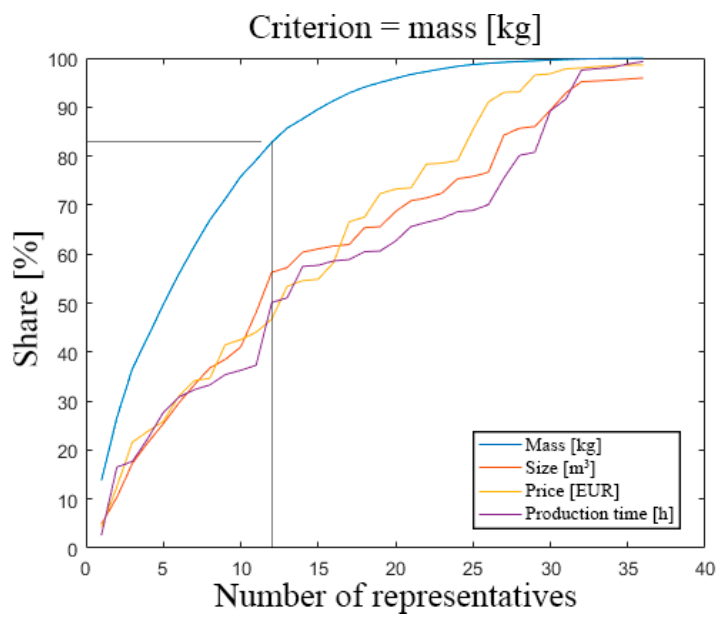
Figure 8. Simulation of descending distribution of representatives by several criteria.